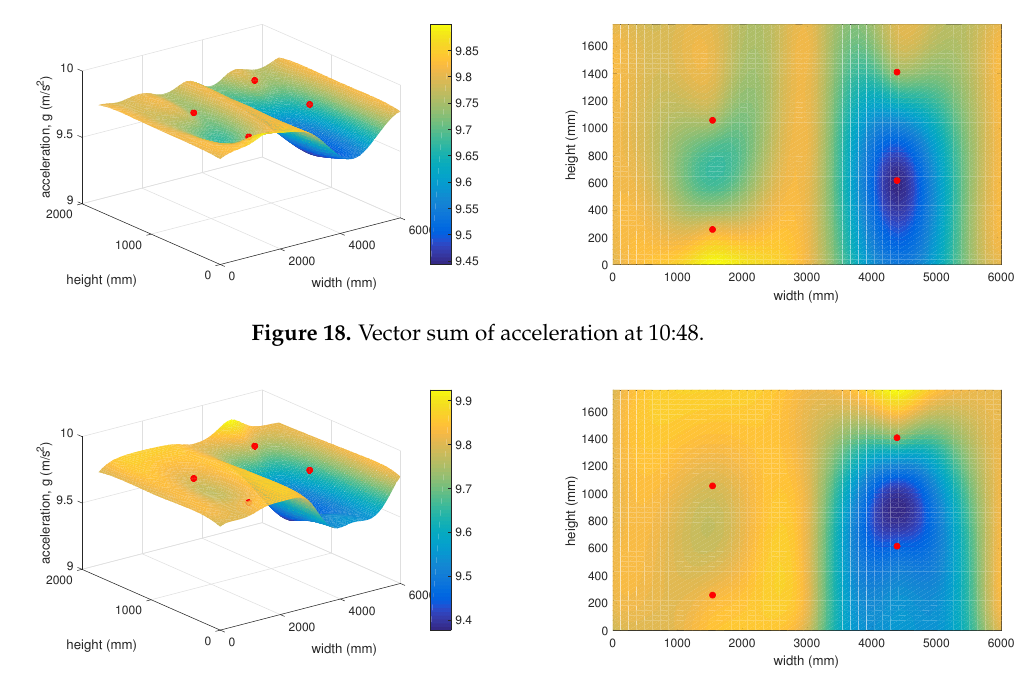
Figure 19. Vector sum of acceleration at